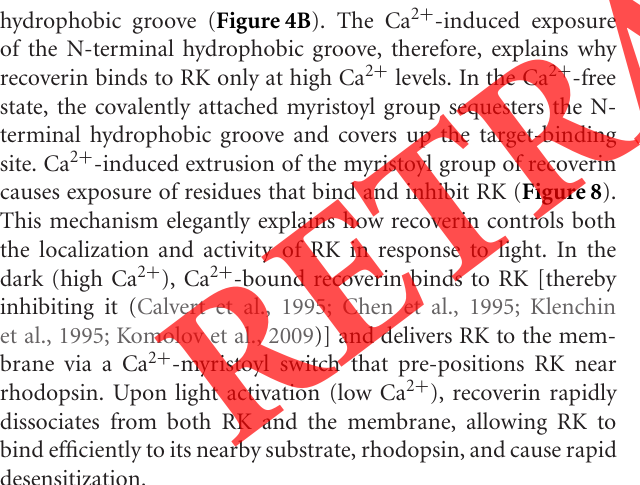
FIGURE 7 | Ribbon diagrams illustrating intermolecular interactions for recoverin bound to RK25 (A), KChIP1 bound to Kv4.32 (B), NCS1 (N-domain) bound to Pik1(111–151) (C), NCS1 (C-domain) bound to Pik1(111–151) (D), and space-filling view of NCS1